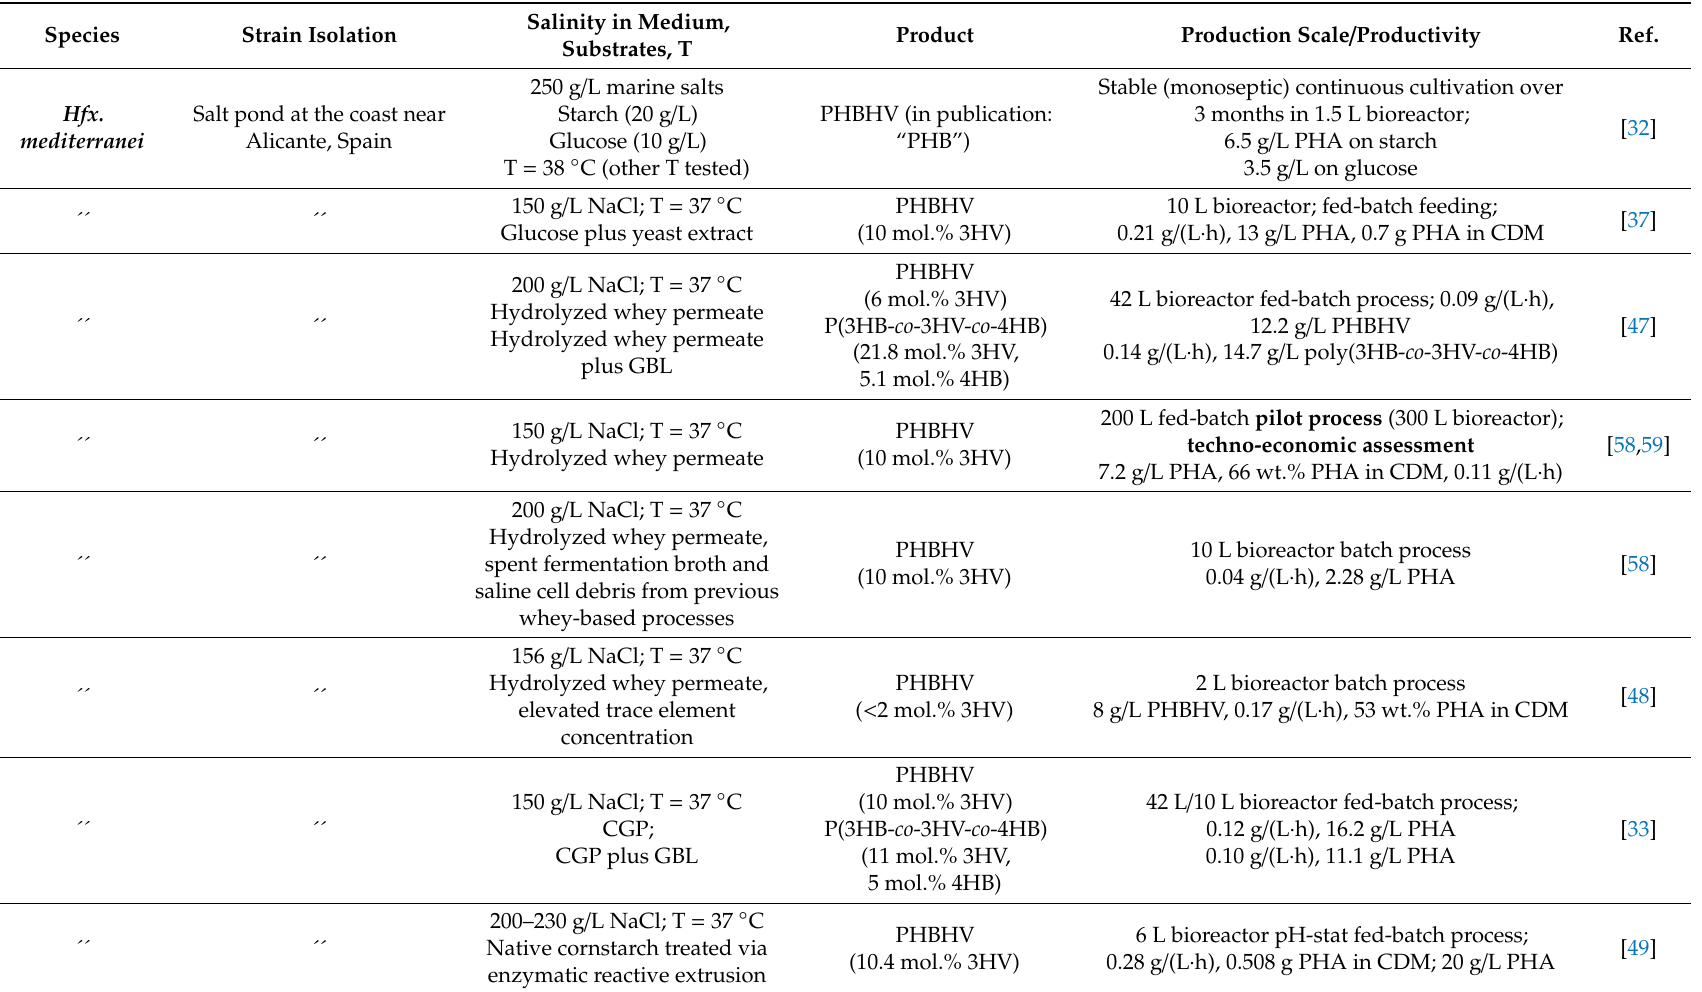
Table 2. PHA production by haloarchaea on bioreactor scale—collected data from